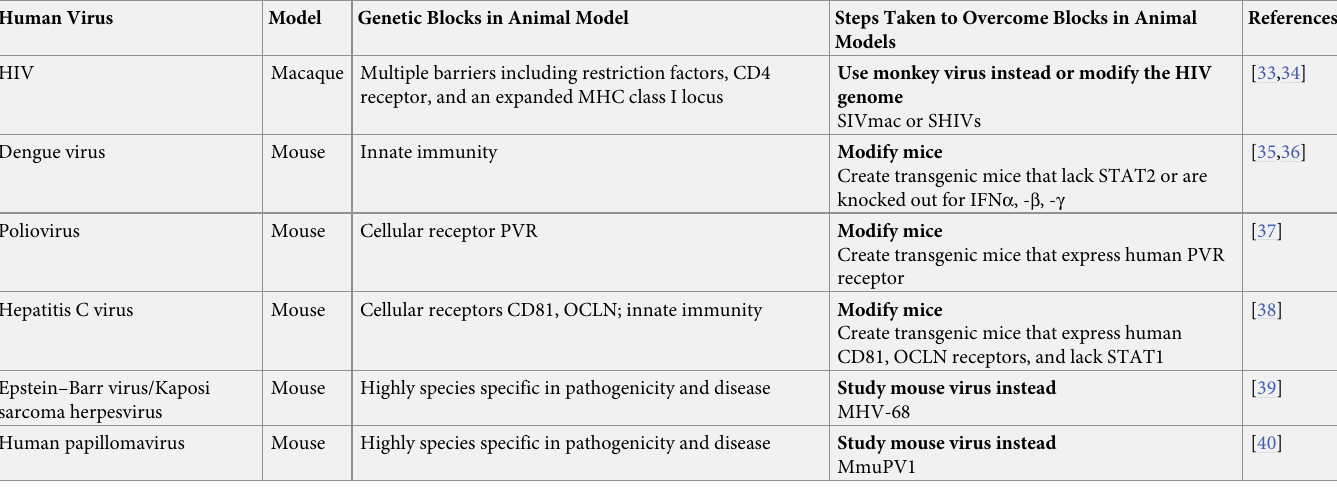
Table 1. Animal models of human viruses as examples of attempted “reverse zoonoses.” Human Virus Model Genetic Blocks in Animal Model Steps Taken to Overcome Blocks in Animal